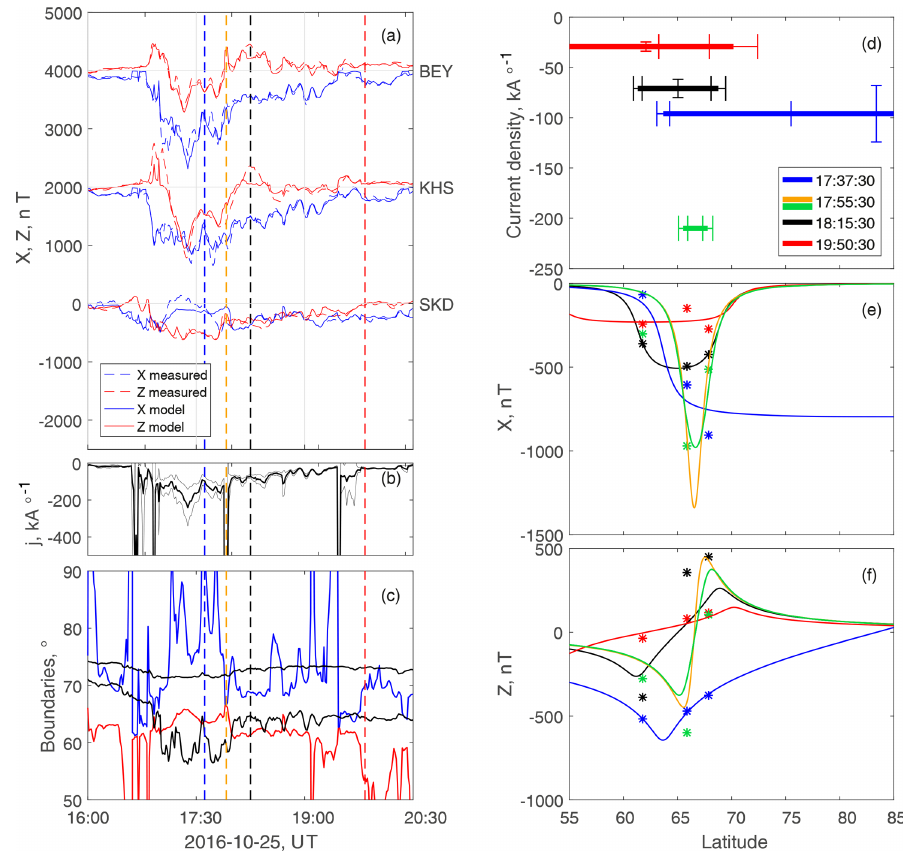
Figure 7. Model 3 for Example 2. Panels (a, b, c) show the measured and magnetic time profiles, the model current density (the standard deviation range is given using thin curves), and the electrojet boundaries (black refers to the Starkov, 1994 model, and blue and red refer to Model 3). Vertical lines denote the time instants for the panels (d, e, f) . Panels (d, e, f) show the latitude cuts with model parameters for four time instants. The error bars in panel (d) show the standard deviations. The measured field is shown using stars, and the model field is shown using lines. Orange illustrates the physically incorrect case which was removed using an additional physical consideration – the current density was forced to be equal to the estimate from Kamide et al. (1982) (see Sect. 3.4 and Appendix B in this paper). The corrected solution is shown using a green